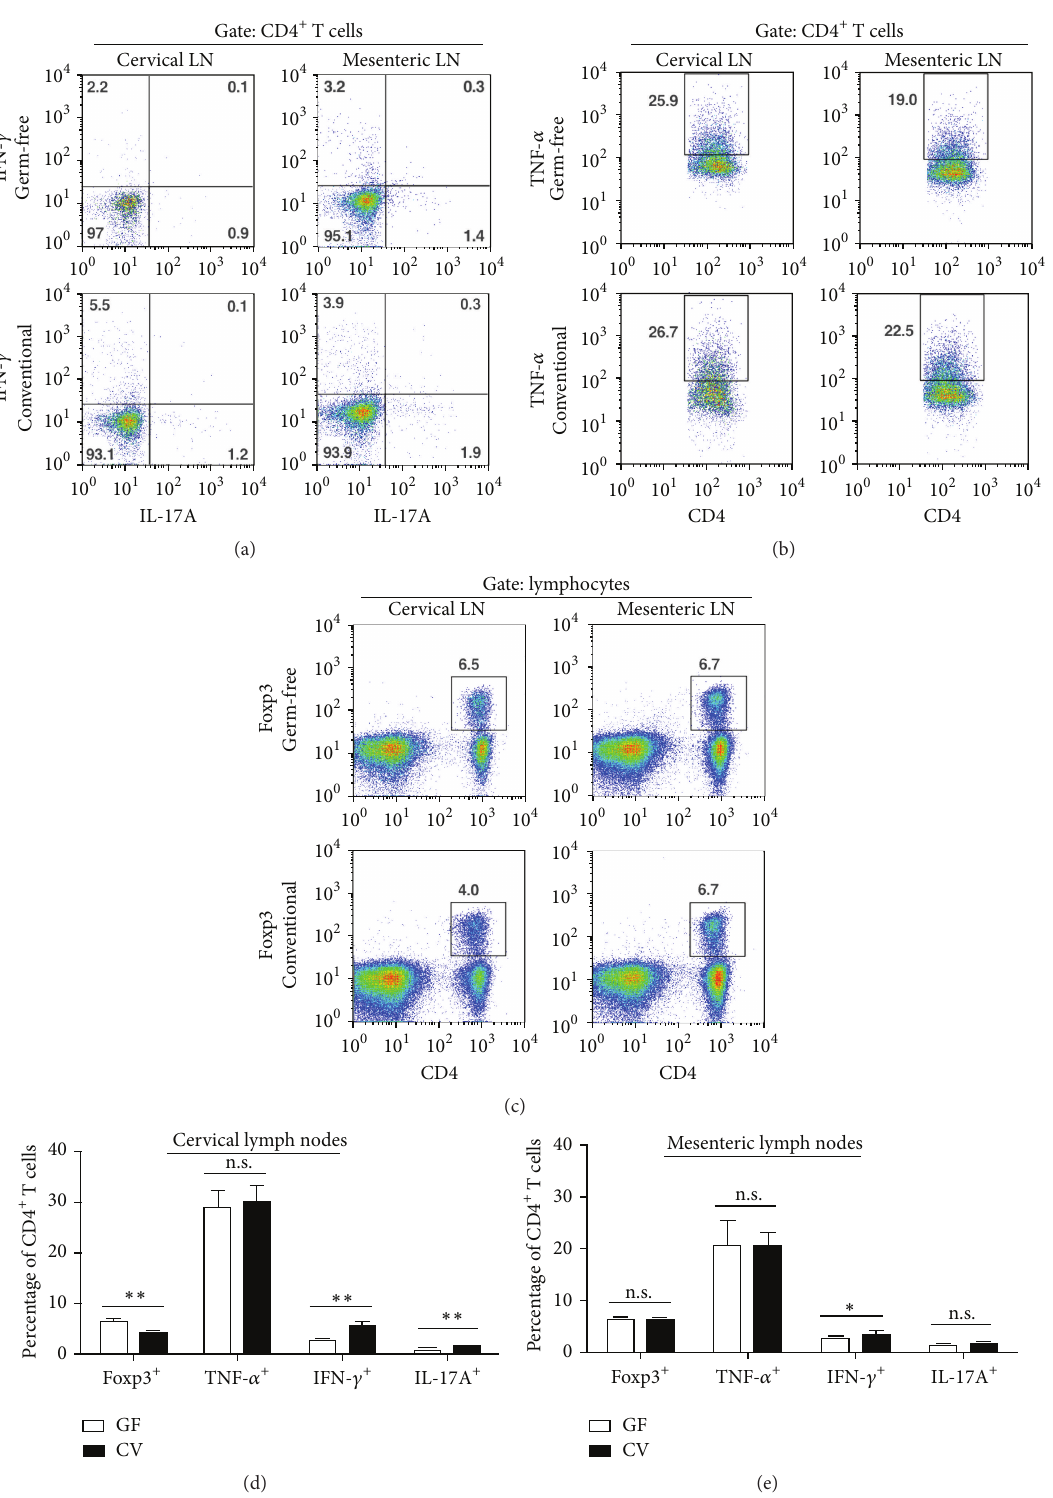
Figure 5: Flow cytometric analysis of lymphocyte populations in cervical and mesenteric lymph nodes. In the cervical lymph nodes of conventional (CV) mice, (a) the percentage of IFN- 𝛾 and IL-17-producing CD4 + T cells increased and (c) the percentage of regulatory Foxp3- expressing CD4 + T cells decreased compared to germ-free (GF) mice. In the mesenteric lymph nodes of CV mice, the environment was less proinflammatory showing only a small but significant increase of IFN-g-producing CD4 + T cells compared to GF mice. In both cervical and mesenteric lymph nodes, (b) the percentage of TNF- 𝛼 -producing CD4 + T cells remained unchanged. The dot plots are representative of two independent experiments. The column graphs summarize the frequency of lymphocyte subpopulations in (d) the cervical and (e) the mesenteric lymph nodes. Each graph represents data from two independent experiments. ∗ 𝑝 < 0.05 , ∗∗ 𝑝 < 0.01 (Mann-Whitney test). n.s. = not